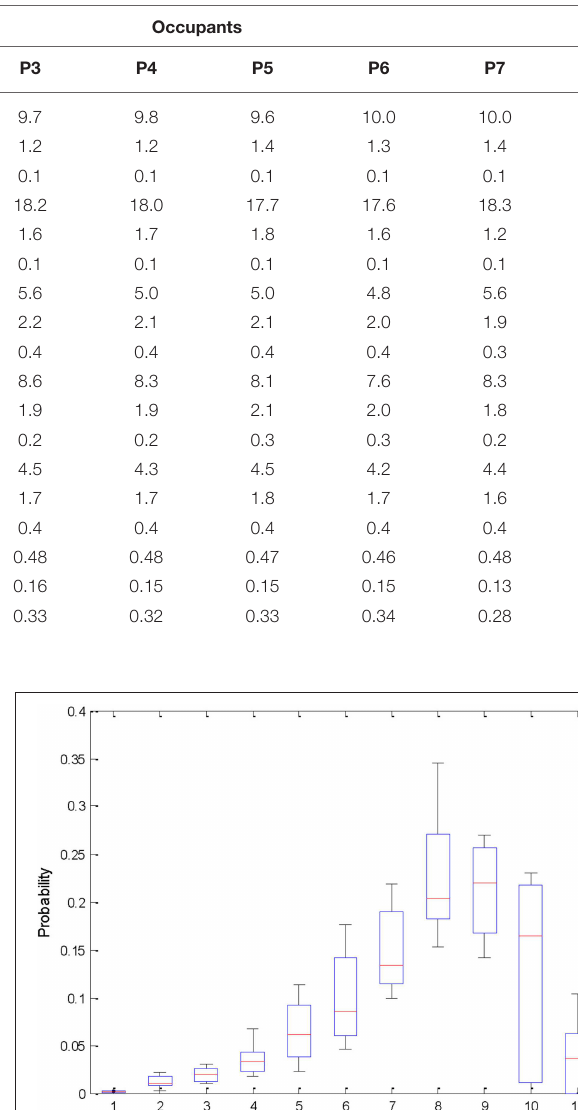
TABLE 3 | Summary of the statistical analysis results [adapted from Mahdavi and Tahmasebi (2015) with permission from A. Mahdavi and F. Tahmasebi]. Indicators